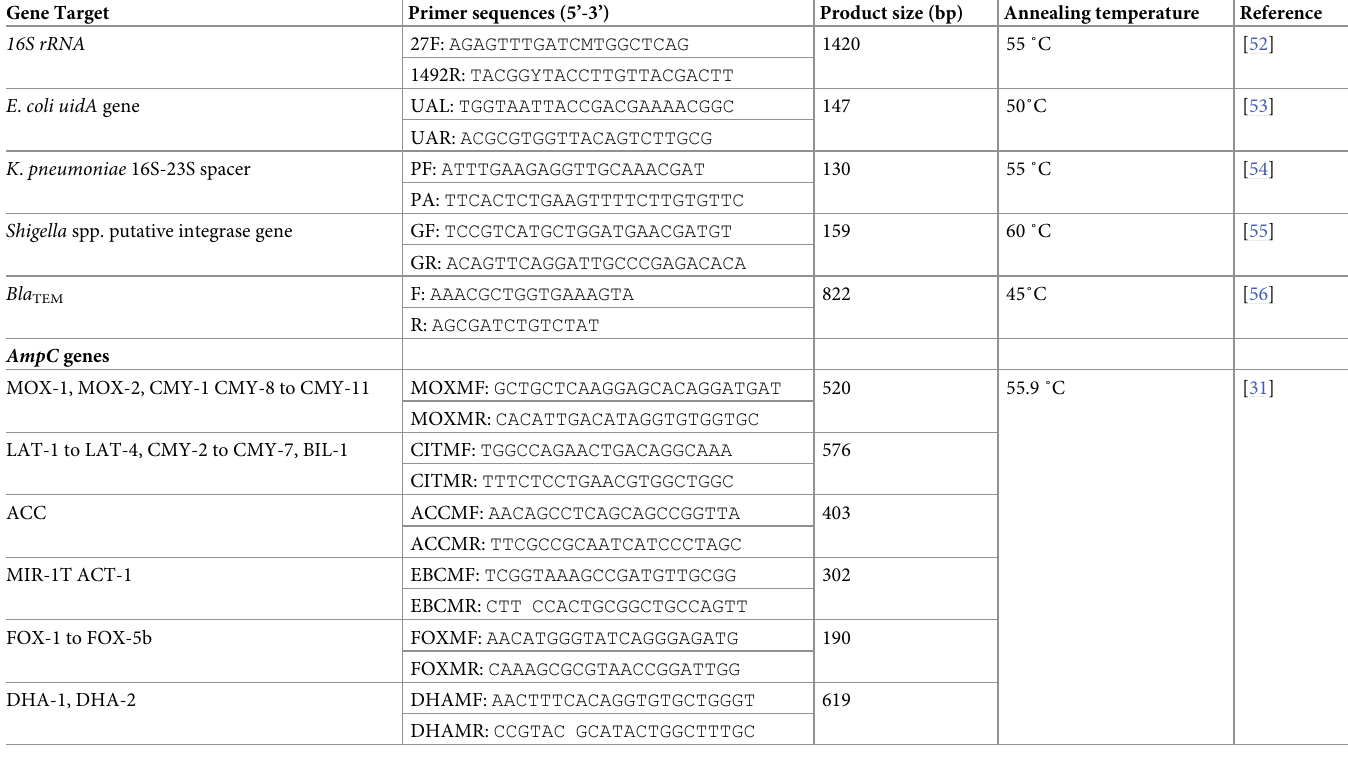
Table 2. Oligonucleotide primer sequences used in the study. Gene Target Primer sequences